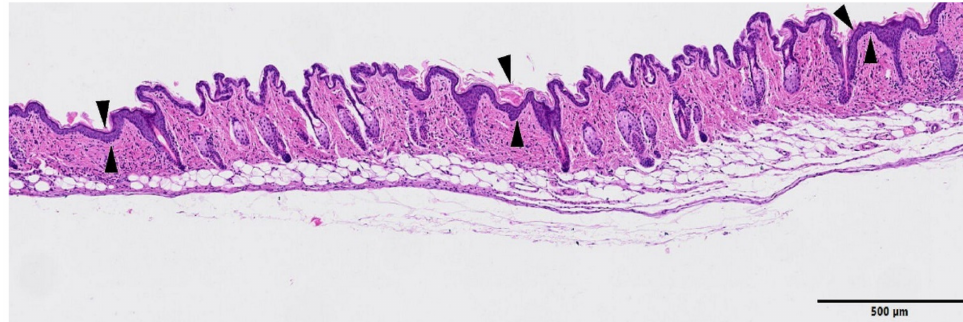
Figure 9. MBRT irradiation. HE staining, Bar = 500 µ m. Three multifocal areas of epidermal hy-perplasia (minimal) are present in the image (arrowheads), where the epidermal layer appears thickened and the subjacent dermis showed lack of annexal structures. On the subjacent correspond- ing areas, there was a decrease in the number of hair follicles, apocrine glands, and sebaceous glands. There was also a minimal and multifocal in-flammatory infiltrate.